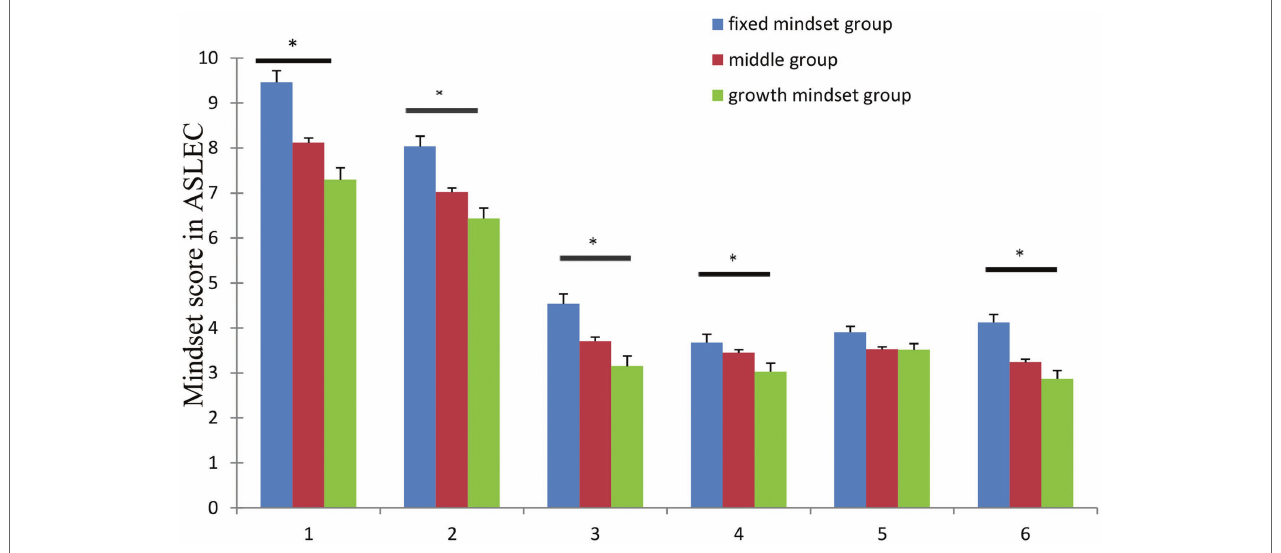
FIGURE 1 | Mean score of subscale of Adolescent Self-rating Life Events Checklist in different groups with error bars representing standard error of the mean and asterisks representing significant difference among groups.